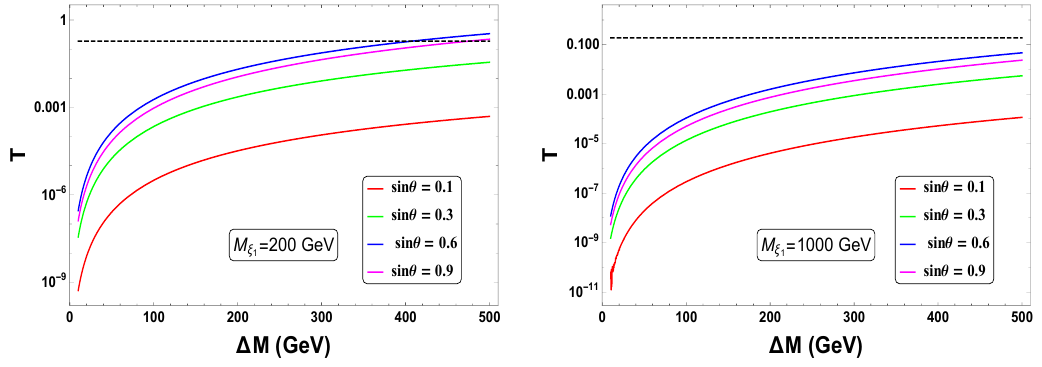
Figure 2 . Sketch of T parameter using eq. (3.2) as a function of ∆ M for two different values of M ξ = 200 GeV (left) and 1000 GeV (right). Each line indicates constant magnitude of sin θ . The 1 black dashed line stands for the observed upper limit of T